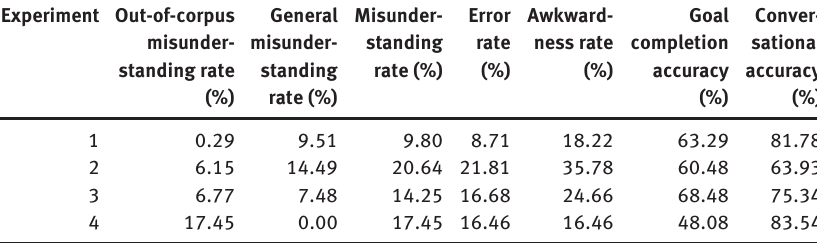
Table 8. Quantitative Analysis of Quality Metrics. Experiment